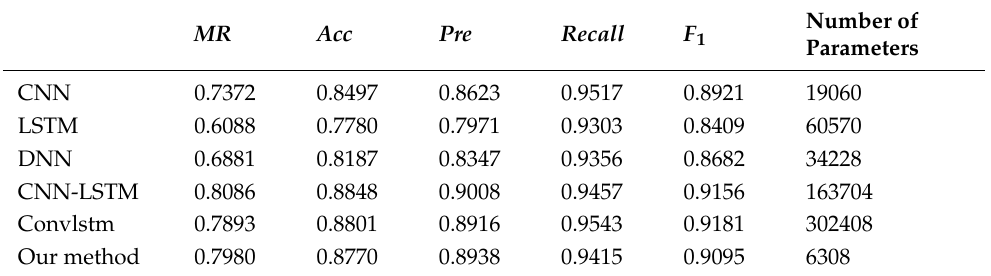
Table 4. Comparison of results of different neural networks in open-circuit fault localization. MR Acc Pre Recall F 1